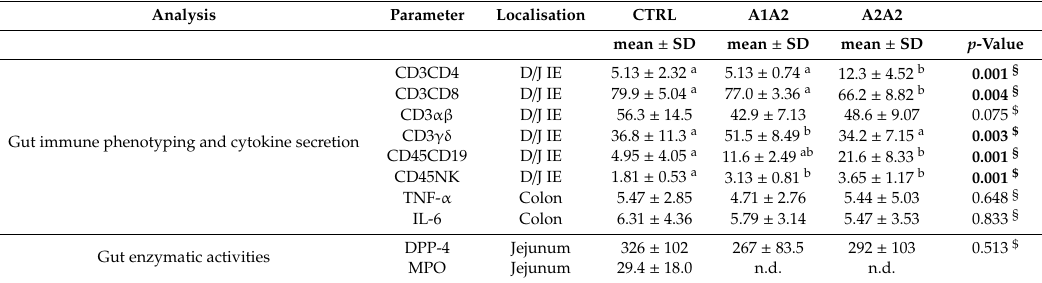
Table 3. Quantification of gut immune phenotyping, cytokine secretion, gut enzymatic